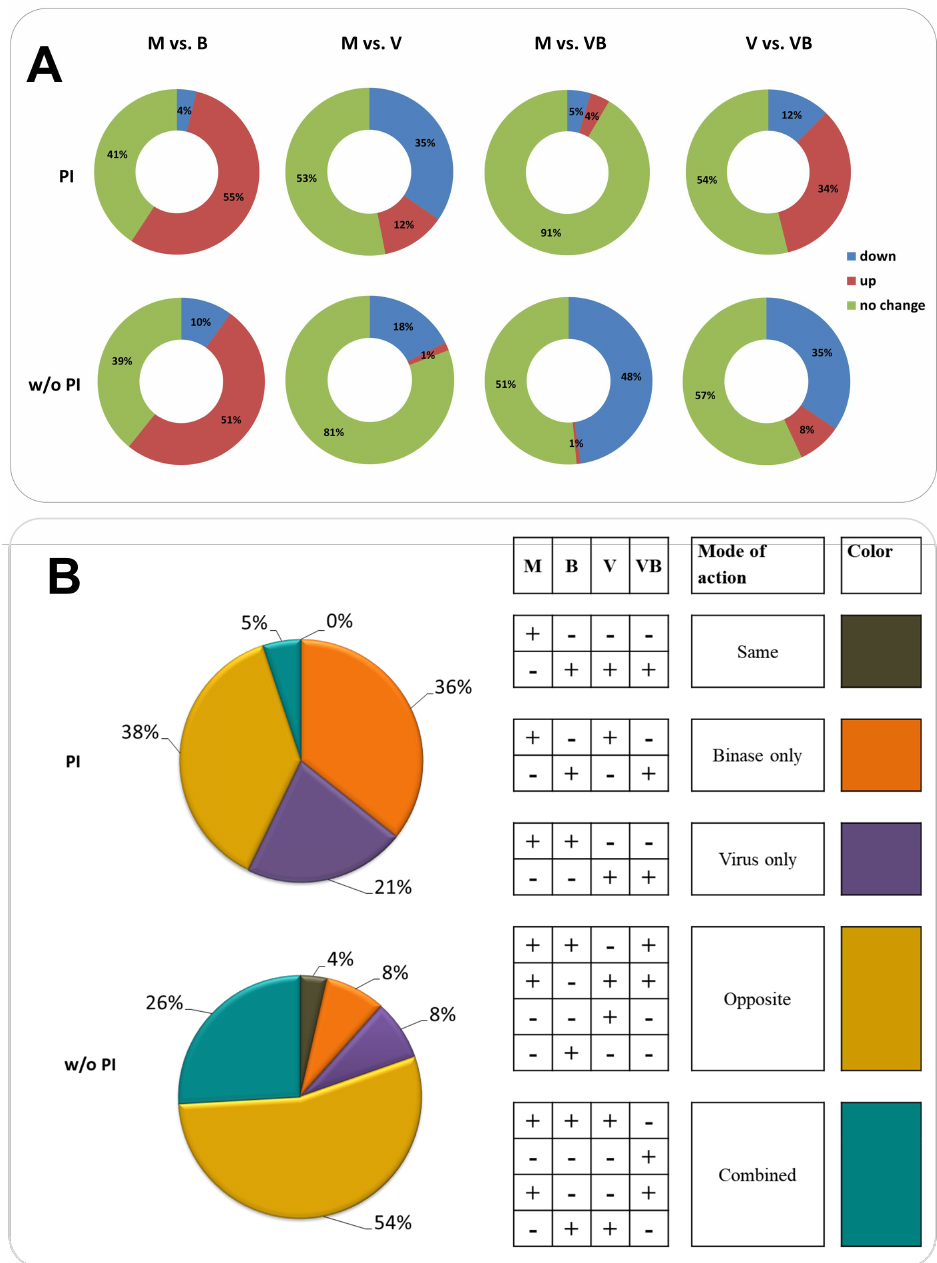
Figure 3. Distribution of proteins between cell samples upon virus infection and binase treatment as determined by targeted LC-MS. ( A ) Distribution of up- and downregulated proteins in cells upon virus infection and binase treatment. M: mock-treated, B: binase-treated, V: virus-treated, and VB: virus and binase-treated). PI: binase and virus were preincubated prior to cell administration and without (w / o) PI: binase was applied to cells after their infection with the virus. ( B ) Distribution of proteins identified in total cell fractions of A549 cells upon virus infection and binase treatment and di ff ering between the samples in their quantity according to the mode of virus and binase actions. The mode of action was assumed on the basis of di ff erences in the quantitative contents of certain proteins between the M, B, V, and VB sample groups. The plus sign indicates that the protein was present or increased ( p -Val ≤ 0.05) in the sample, while the minus sign indicates that the protein was absent or decreased ( p -Val ≤ 0.05). The coloring for the chart is related to the colors of groups in the right table, which were formed based on the mode of action of the virus and / or binase. Same action means that the same proteins were changed by the influenza A virus (IAV) infection or binase treatment (grey). When the proteins were significantly changed only in the samples treated by binase, they were grouped into the category “binase only” (orange). The same rule was applied for “virus